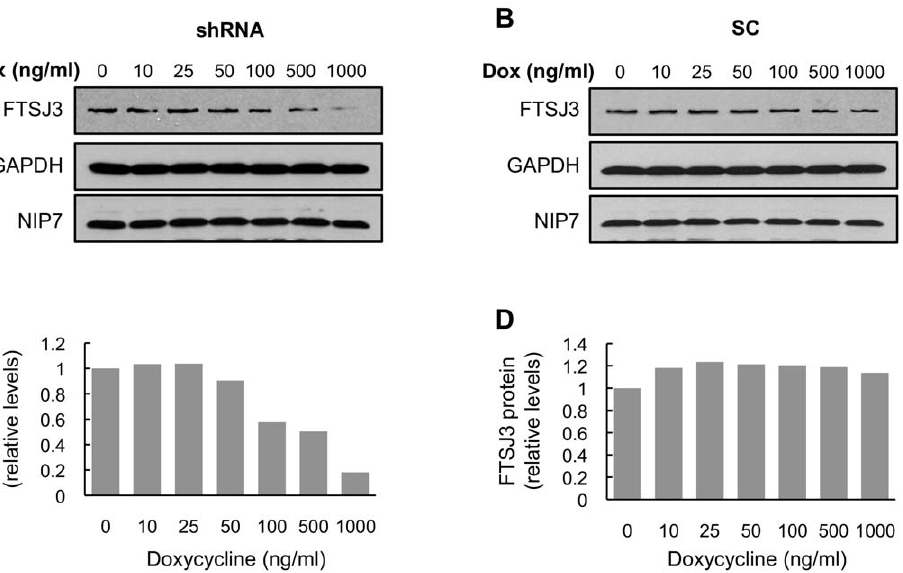
Figure 4. Analysis of FTSJ3 knockdown by RNA interference using the pFRT-U6tetO inducible system. ( A, B ) Western blot analysis to determine FTSJ3 levels in HEK293 Flp-In T-Rex cells expressing either a small hairpin RNAs targeting FTSJ3 (shRNA) or a scrambled control (SC) 72 h after induction with doxycycline (Dox). FTSJ3 levels decrease upon induction of the shRNA with doxycycline in dose-dependent manner. NIP7 levels are not affected by depletion of FTSJ3. ( C, D ) FTSJ3 relative levels were determined by band quantification using ImageJ software and normalized to GAPDH, which was used as an internal control. FTSJ3 was reduced to 20% of its original levels in cells treated with doxycycline at 1000 ng/ml.